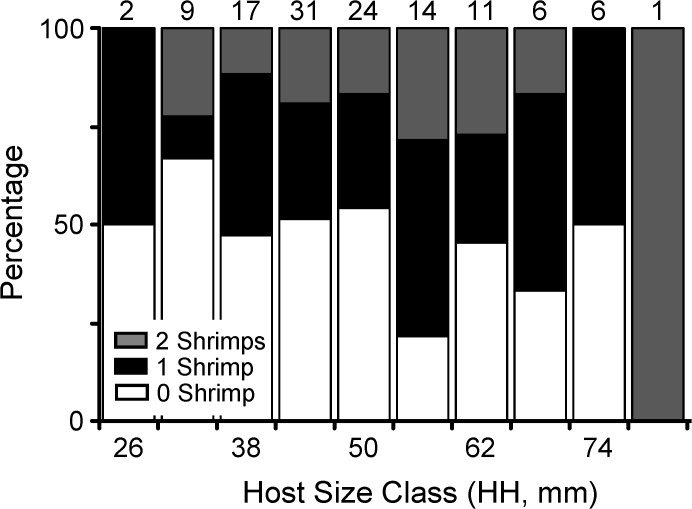
The effect of host body size in host use by Odontonia katoi.Frequency of occurrence of Odontonia katoi shrimps in ascidian host individuals of different size classes at Kimbe Bay, Papua New Guinea (see Results for further details).